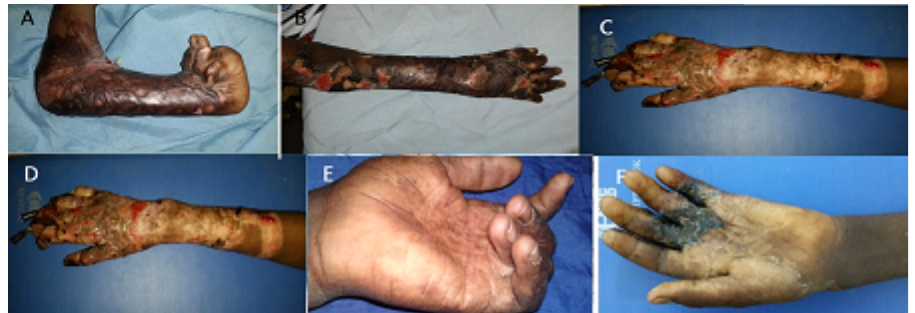
Figure 3 : Skin graft.